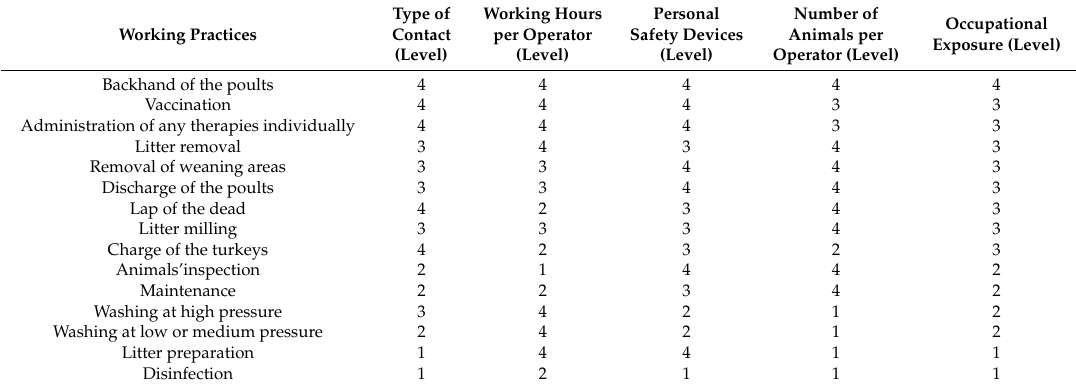
Table 10. Level of occupational exposure to ESBL in descending order for each of the working practices in the fattening turkey farming, as obtained by a modified FMEA. When two or more practices have the same ranking, they are ordered according to the tie-break